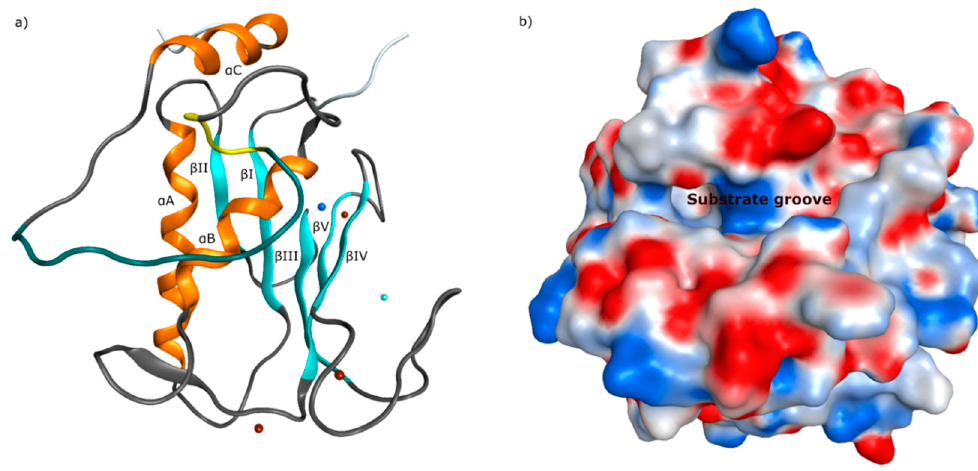
Figure 4. ( a ) Ribbon structure of catMMP-13 (PDB ID: 2OW9) [73] showing five beta-sheets and three alpha-helices (catalytic zinc(II) ion as blue and structural zinc(II) ion as cyan sphere, calcium(II) ions as brown spheres), ( b ) electrostatic surface of catMMP-13 with the substrate recognizing groove.